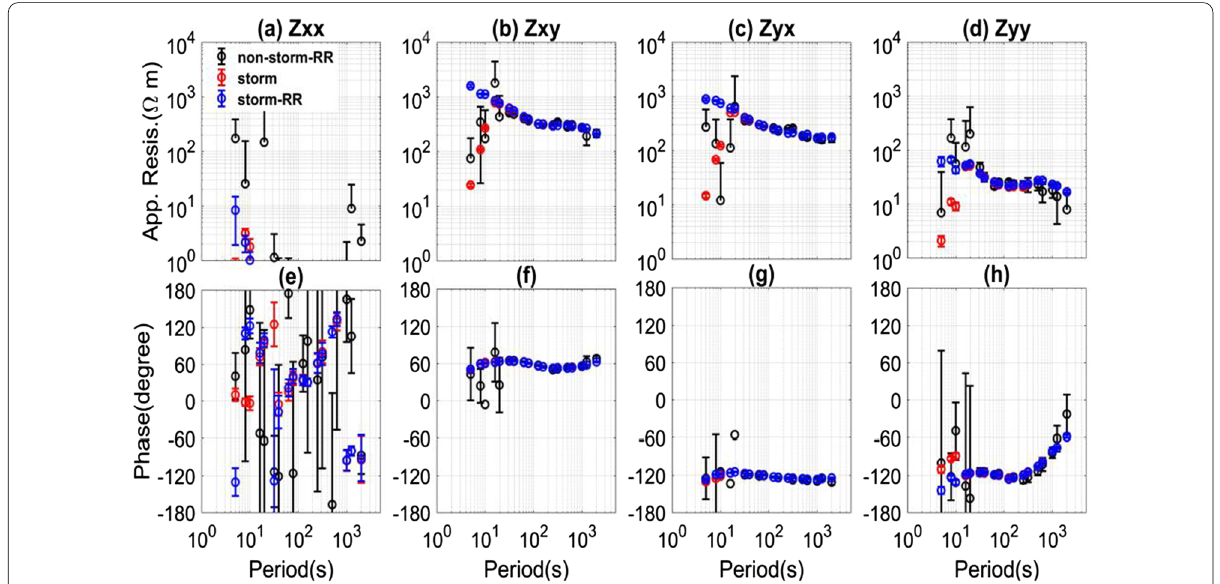
Fig. 16 Comparison of the MT sounding curves calculated by single-site and remote reference data processing using the storm and non-storm data observed at site TNV48. a – d Show the apparent resistivity. e – h Show the impedance phase. The horizontal axis denotes the period in seconds. The MT sounding curves longer than 40 s are similar and cover the XY and YX